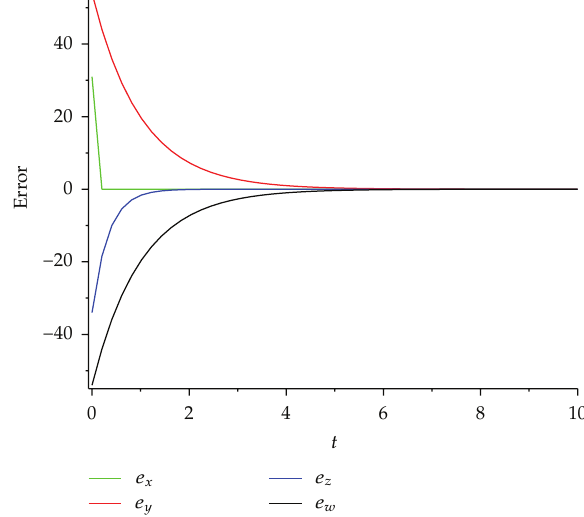
Figure 9: It shows that the behaviour of the trajectories e x ,e y ,e z , and e w of the hyperchaotic L¨u system error system tends to zero as t tends to 5 when the scaling factor α (cid:8) 5.